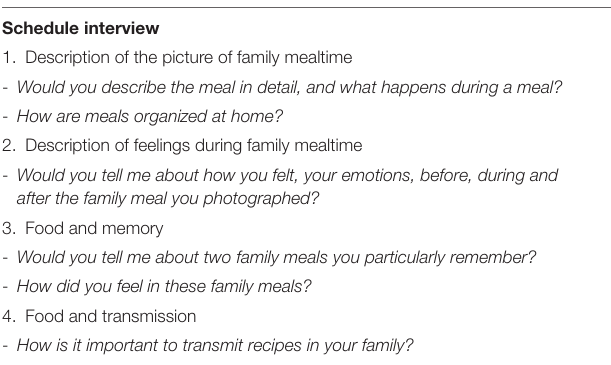
TABLE 2 | Guide for semi-structured